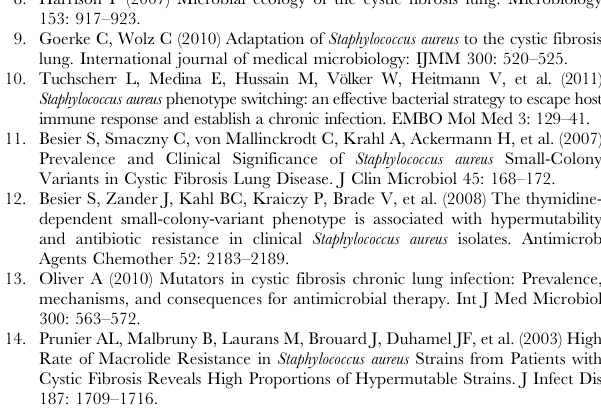
Table S1 Genetic polymorphisms identified among the CF S.